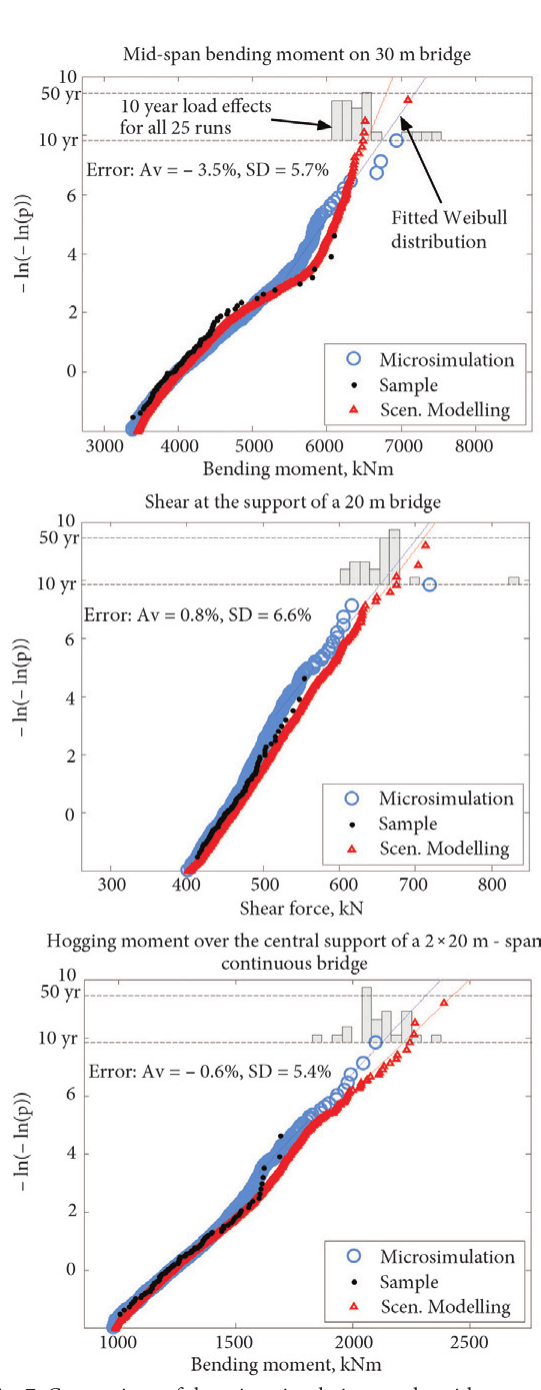
Fig. 7. Comparison of the microsimulation results with one of the Scenario Modelling runs, with a histogram showing the results for all 25 Scenario Modelling